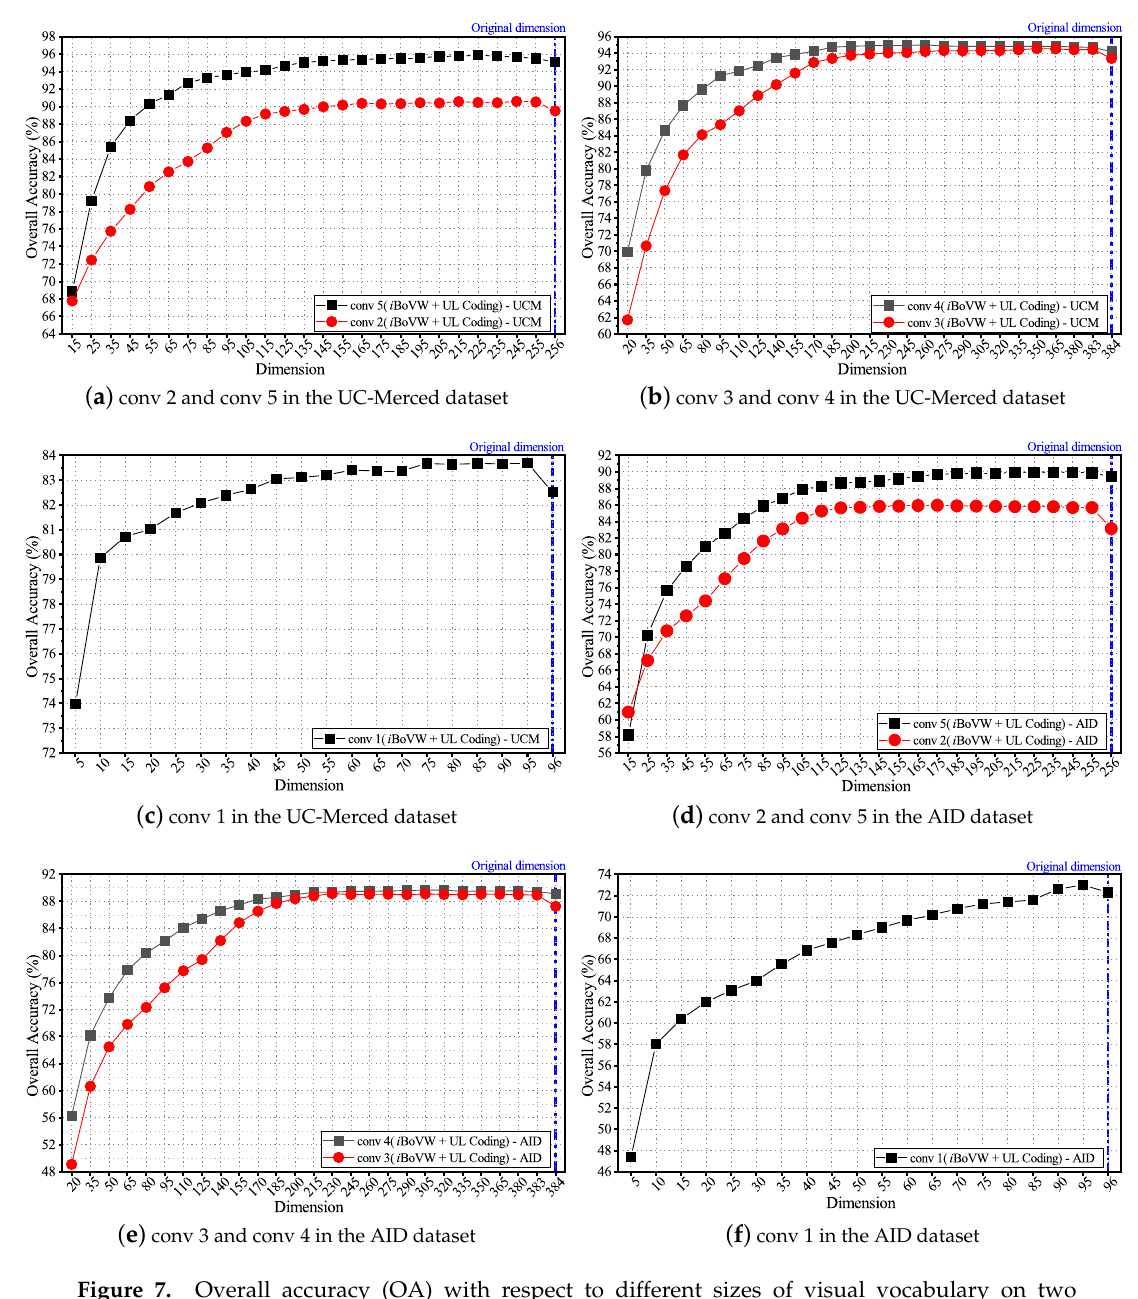
Figure 7. Overall accuracy (OA) with respect to different sizes of visual vocabulary on two public